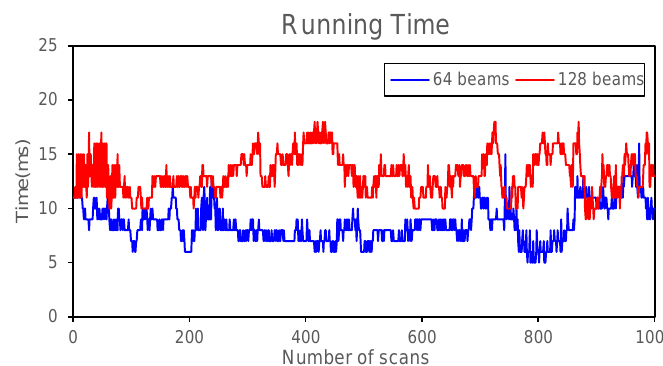
Figure A1. The running time of our method on 1000 consecutive